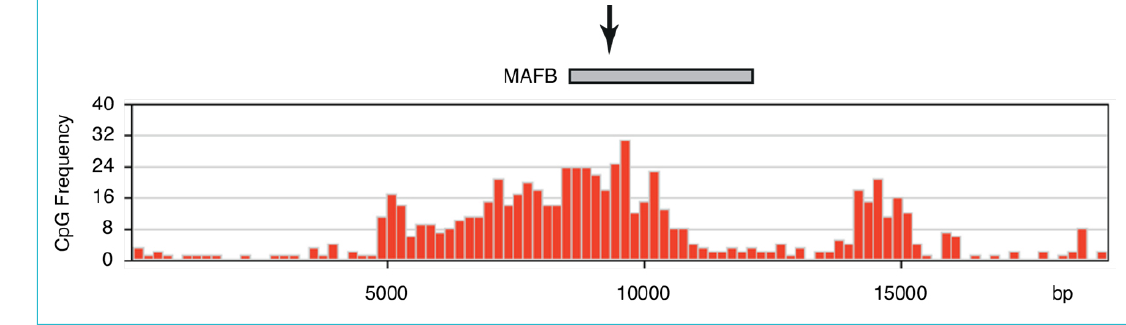
Figure 5: The mutation occurs in a typical CpG island. The frequency of CpG dinucleotides within a window of 200 is depicted along the genomic sequence of human chromosome 20 at the region of the MAFB gene. A grey box shows the single exon of the MAFB gene. An arrow indicates the site of mutation. This site is located in a region with relatively high CpG content (25 CpG/200 nt), whereas the regions further up- stream and downstream have a very low CpG content (0–3 CpG/200